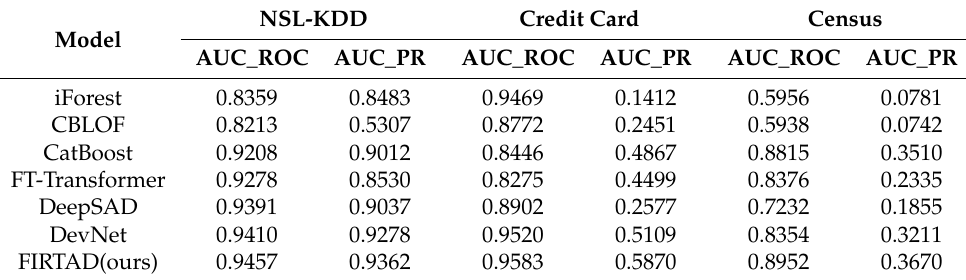
Table 2. Performance